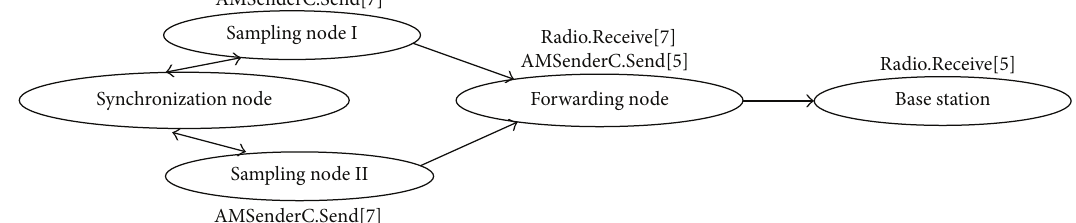
Figure 14: Workflow of data communication.